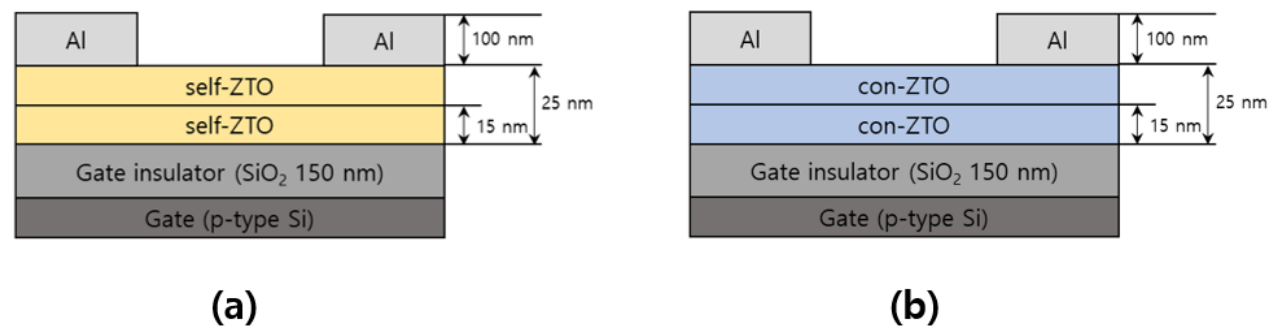
Figure 1. Cross-sectional schematics of ( a ) con-ZTO and ( b ) self-ZTO DAL TFTs